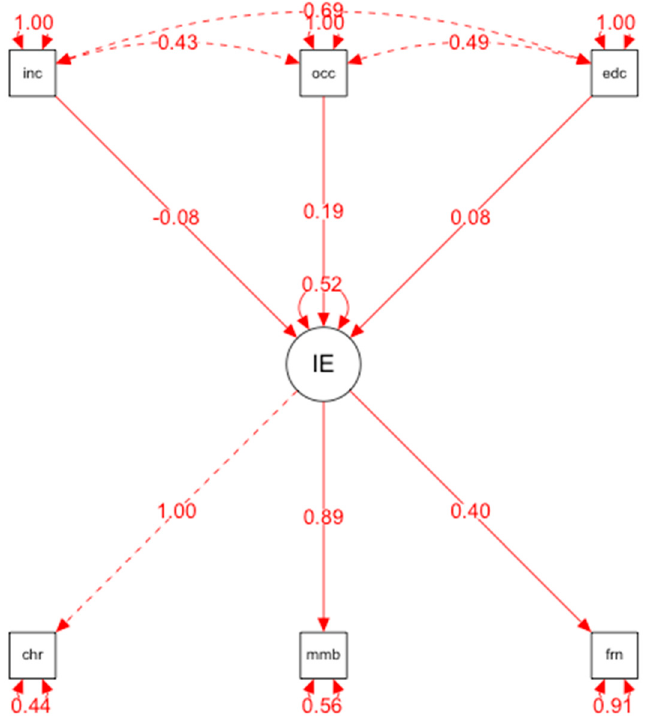
Figure 1. Structural equational modeling. INC: emotional attention. OCC: emotional clarity. EDC: emotional regulation. CHR: relation. MMB: autonomy. FRM: competence.